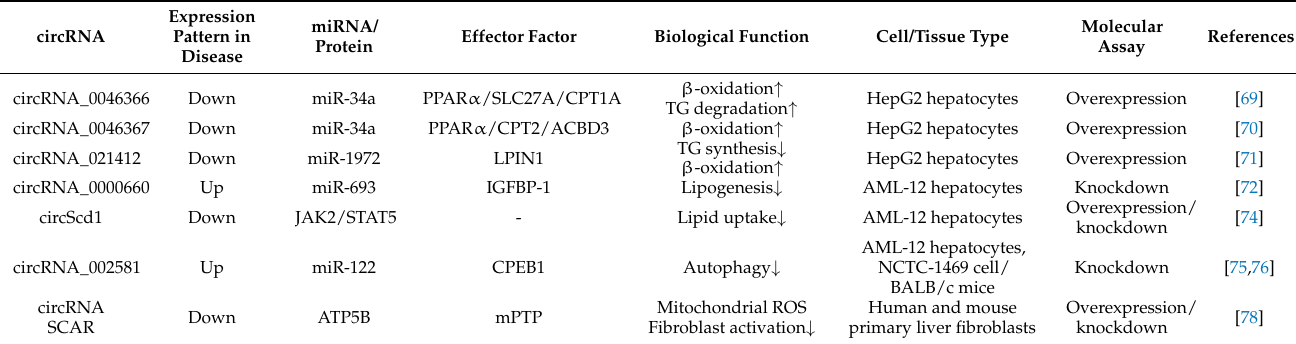
Table 2. Circular (circ)RNAs in hepatocellular lipid